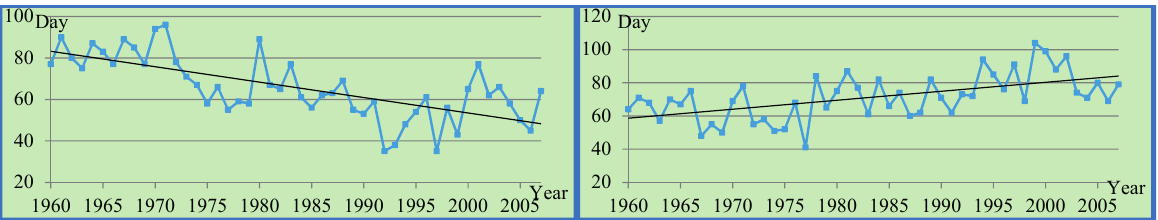
Figure 6. The most significant negative trend with a slope of − 1.4889 ( left ) and the most significant positive trend with a slope of 1.1588 ( right ) of the CWD index.